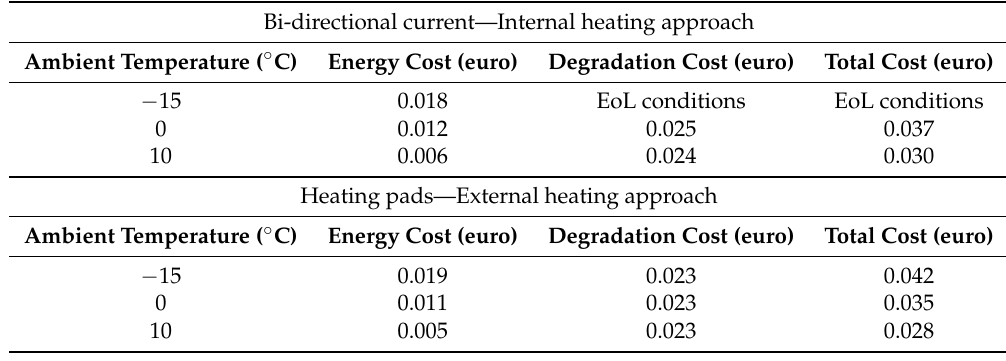
Table 4. Costs for 8 h preheat with bi-directional current pulses method for the NMC/G pouch